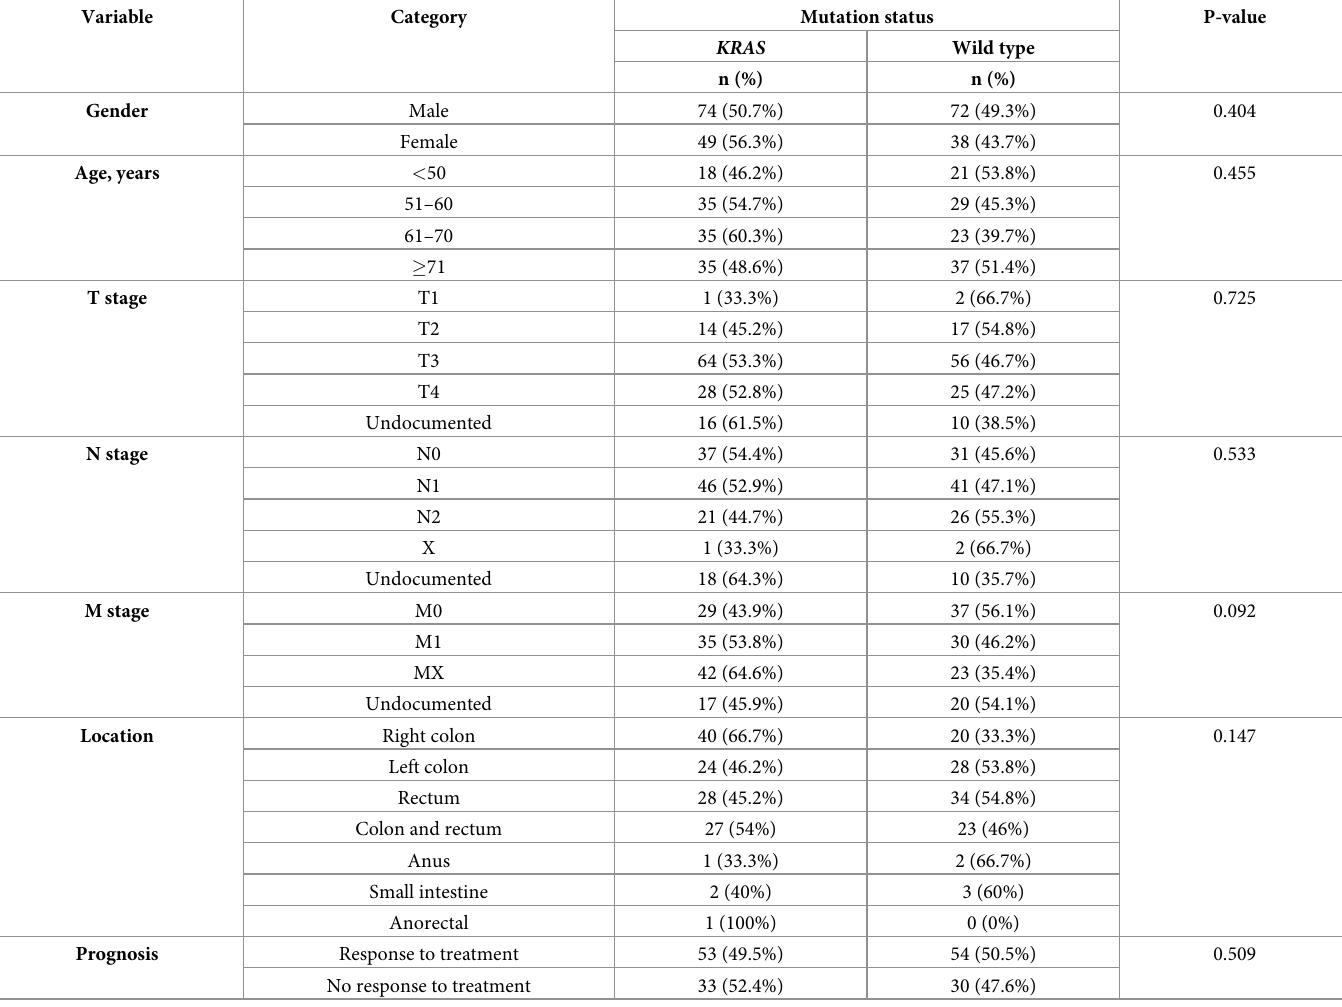
Table 1. Results of Chi-Squared tests of association between mutational status and demographic and clinicopathological